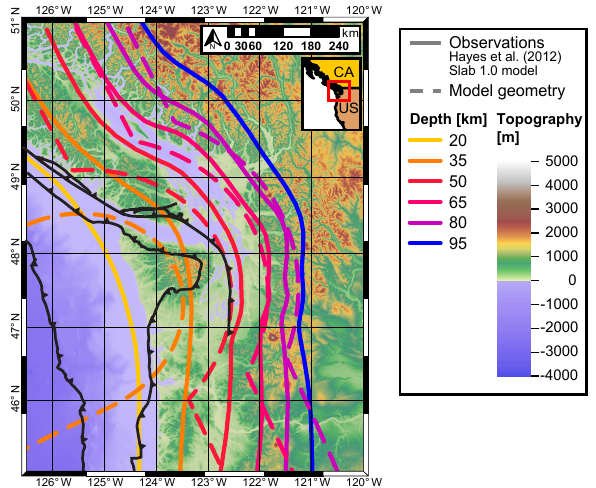
Figure 1. Observed subducting plate geometry and simplified model representation for the Cascadia subduction zone. Model ge- ometry was chosen to best conform to the forward bulge of the down-going plate. The rotational shape and straight background slab of the model geometry allow consistent velocity boundary con- ditions and reduce edge effects. Slab contours from Hayes et al. (2012) Slab 1.0 global subduction zone geometry model; major structures in black from Brandon et al.